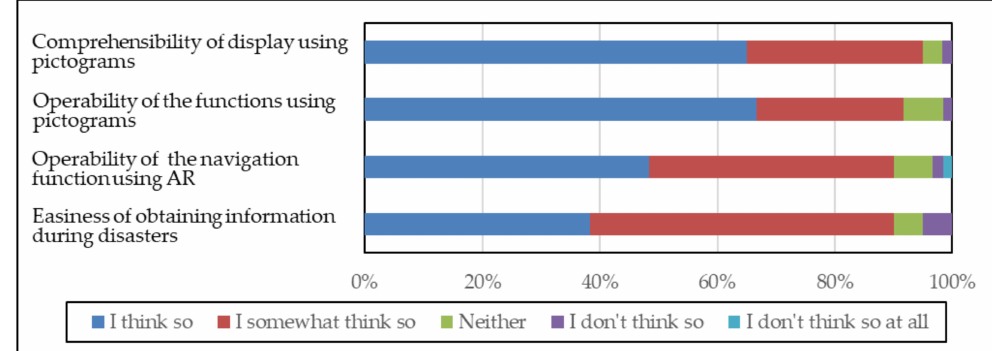
Figure 11. Evaluation results of the originality of the system.